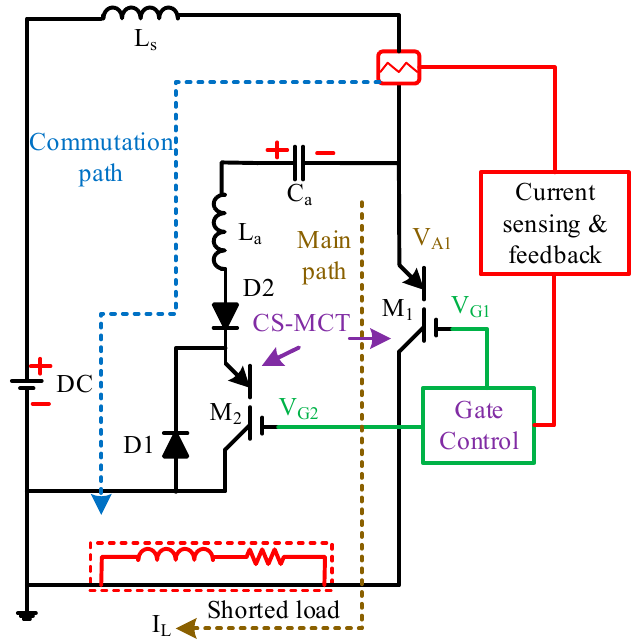
Figure 11. Schematic of SSCB based on CS-MCT using mixed-model simulation [36].